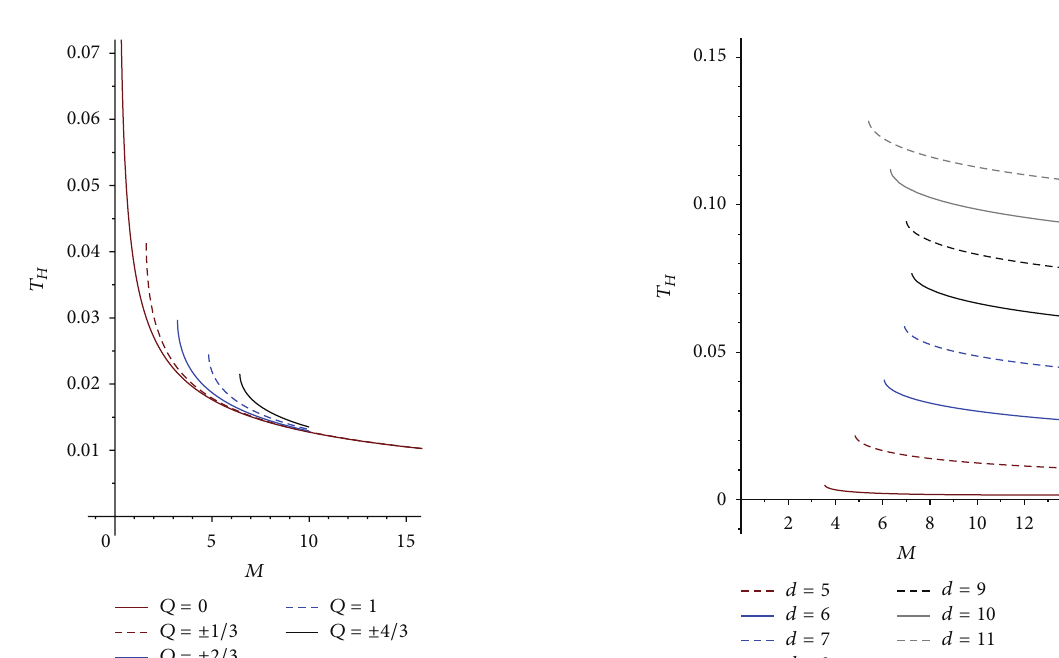
Figure 2: Hawking temperature with respect to the mass in terms of